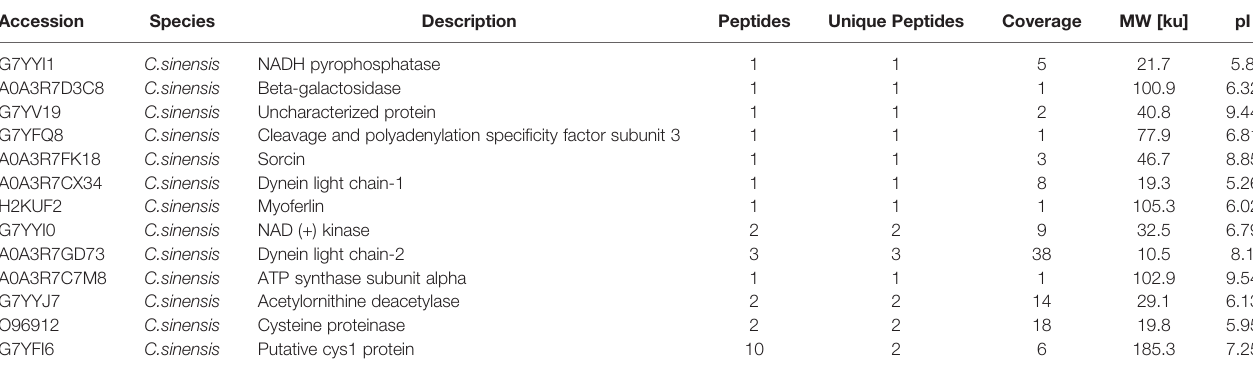
TABLE 1 | Clonorchis sinensis excretory and secretory products which were detected by sera of rabbits in 7 dpi. Accession Species Description Peptides Unique